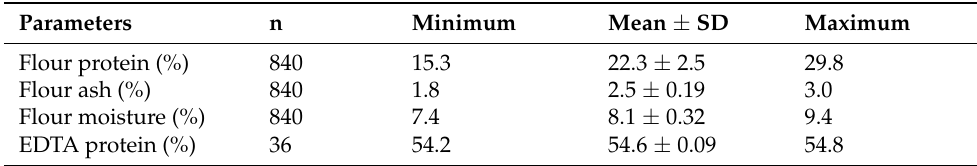
Table 2. Minimum, mean, and maximum protein concentration (%) for flour and EDTA, flour ash concentration (%), and moisture content (%).